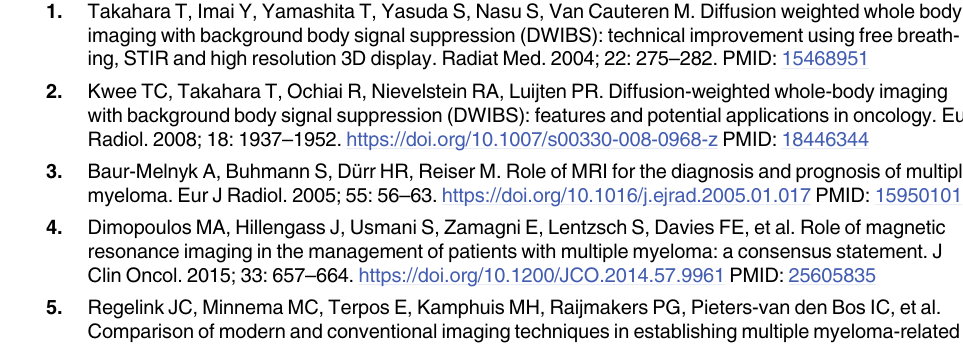
S1 Fig. Overall survival and cell morphology. There was no stratification in cell morphology. (TIF) S2 Fig. Evaluation using apparent diffusion coefficient (ADC) responder, 0.103 ± 0.191 × 10 − 3 mm 2 /s; for non-responder + stable, -0.117 ± 0.209 × 10 − 3 mm 2 /s. Δ ADC for responder, 0.144 ± 0.235 × 10 − 3 mm 2 /s; for non-responder + stable, average -0.126 ± 0.270 × 10 − 3 mm 2 /s. (TIF) S3 Fig. Overall survival and Durie–Salmon staging system. Conventional prognostic indica- tors were analyzed for the target group of this study and all cases in our facility between 2009– 2020. No classification presented a clear stratification. As an example, the Durie–Salmon clas- sification system is shown. MM, multiple myeloma.